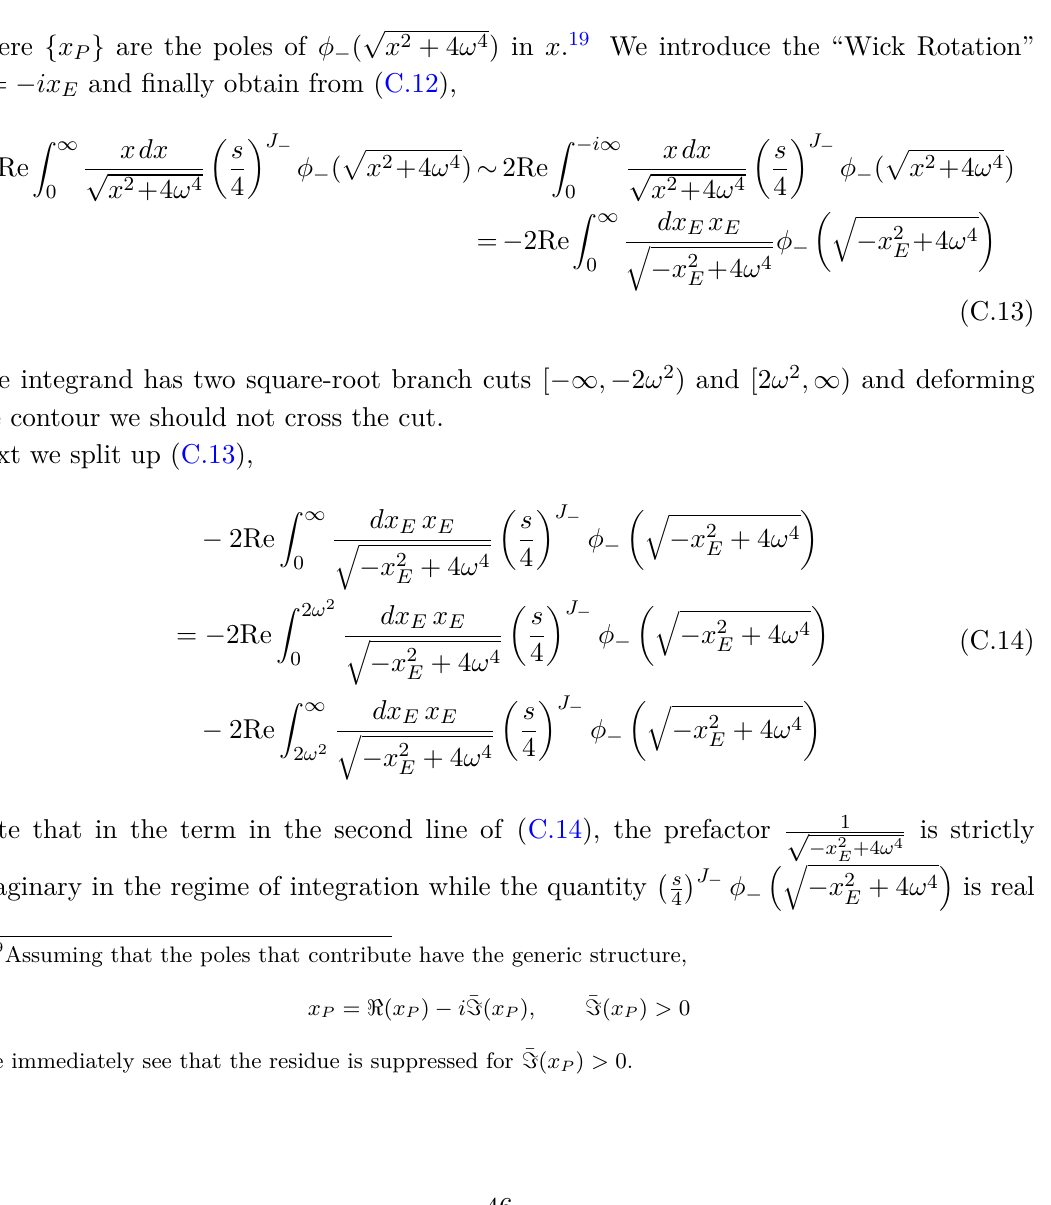
Figure 2 . Contour Prescription for